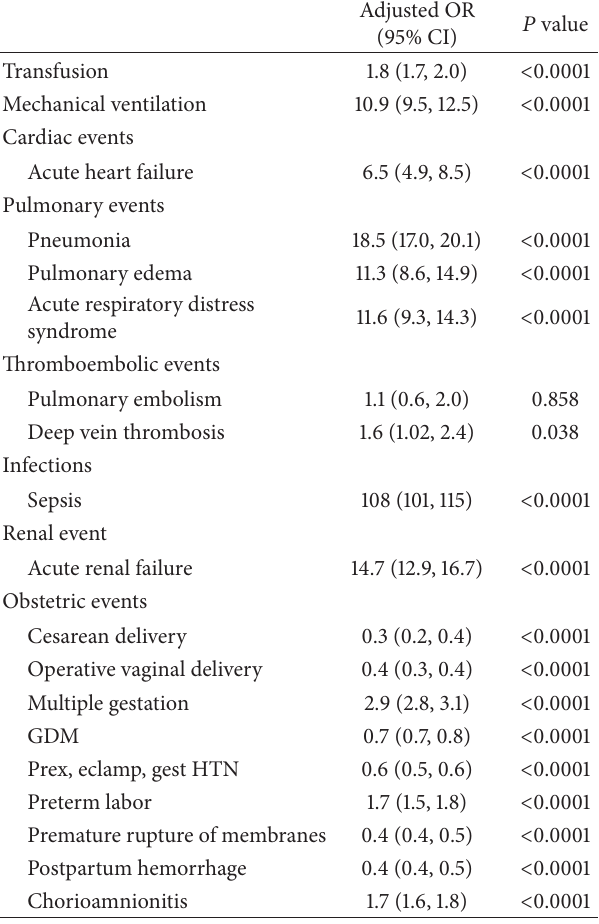
Table 5: Multivariable logistic regression analysis for the listed outcomes among women with pyelonephritis compared to women without pyelonephritis, while controlling for age, private insurance, residing in a ZIP code with annual income at lowest quartile, cardiomyopathy, asthma, diabetes, thyroid disorders, systemic lupus erythematous, anemia, thrombocytopenia, sickle cell disease, drug use, alcohol use, tobacco use, chronic hypertension, and chronic renal